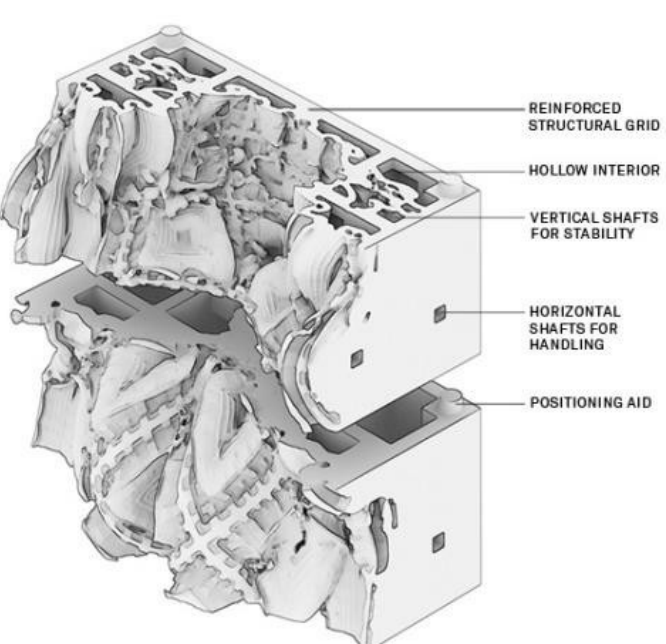
Figure 9. Isometricassembly detail of the mass